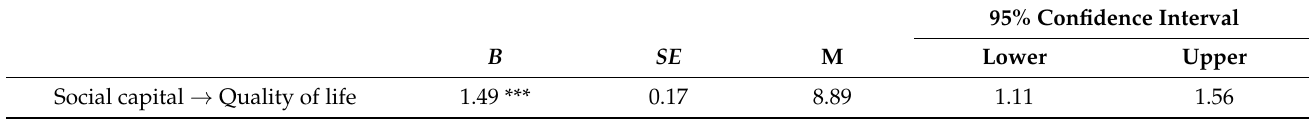
Table 4. Direct effect of social capital on Quality of life.